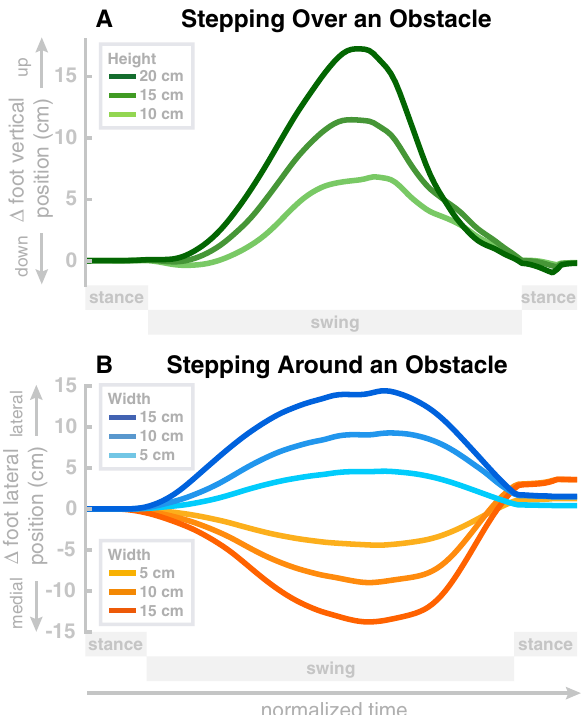
Figure 6. Avoiding obstacle during steady-state walking. Panel ( A ) shows the change from the normal trajectory without obstacle in the vertical direction when stepping over obstacles of varying height. Panel ( B ) shows the change from the normal trajectory without obstacle in the medial-lateral direction when stepping around obstacles of varying width, in either direction. Both panels show the movement from left heel-strike to push-off of the stance